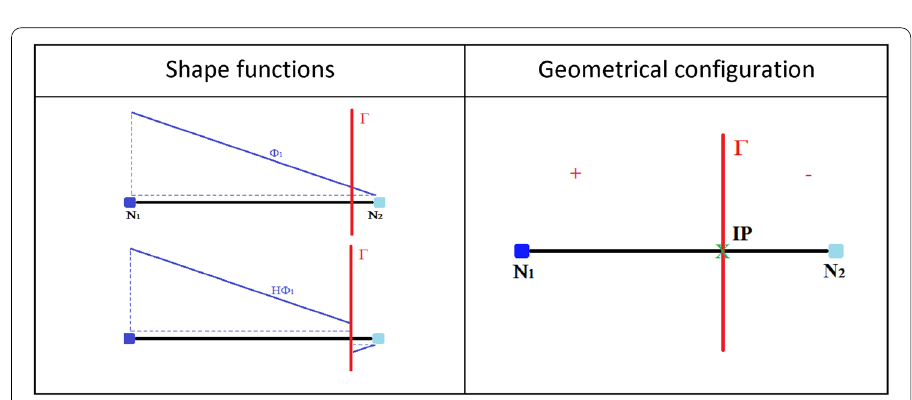
Fig. 1 Positions of the interface investigated in the paper. The condition number is optimal in two cases: firstly, when the interface cuts through the middle of the elements and secondly, when the interface is on the boundary of the elements. Apart from those cases, the condition number soars. This behavior will be investigated later in the paper